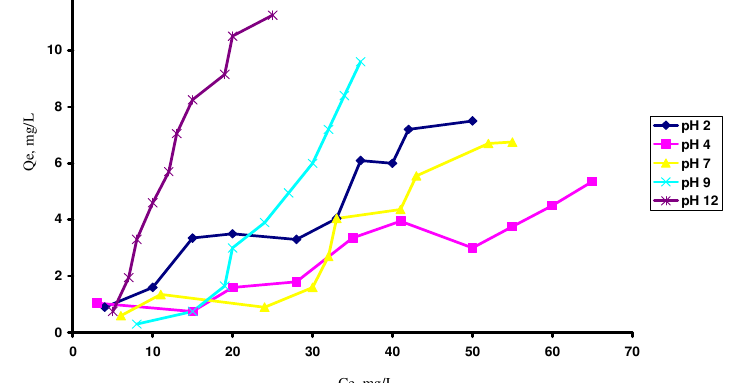
Figure 7. Removal of colour from aqueous solution of sulphanilic azo imidazole at various pH Contact time